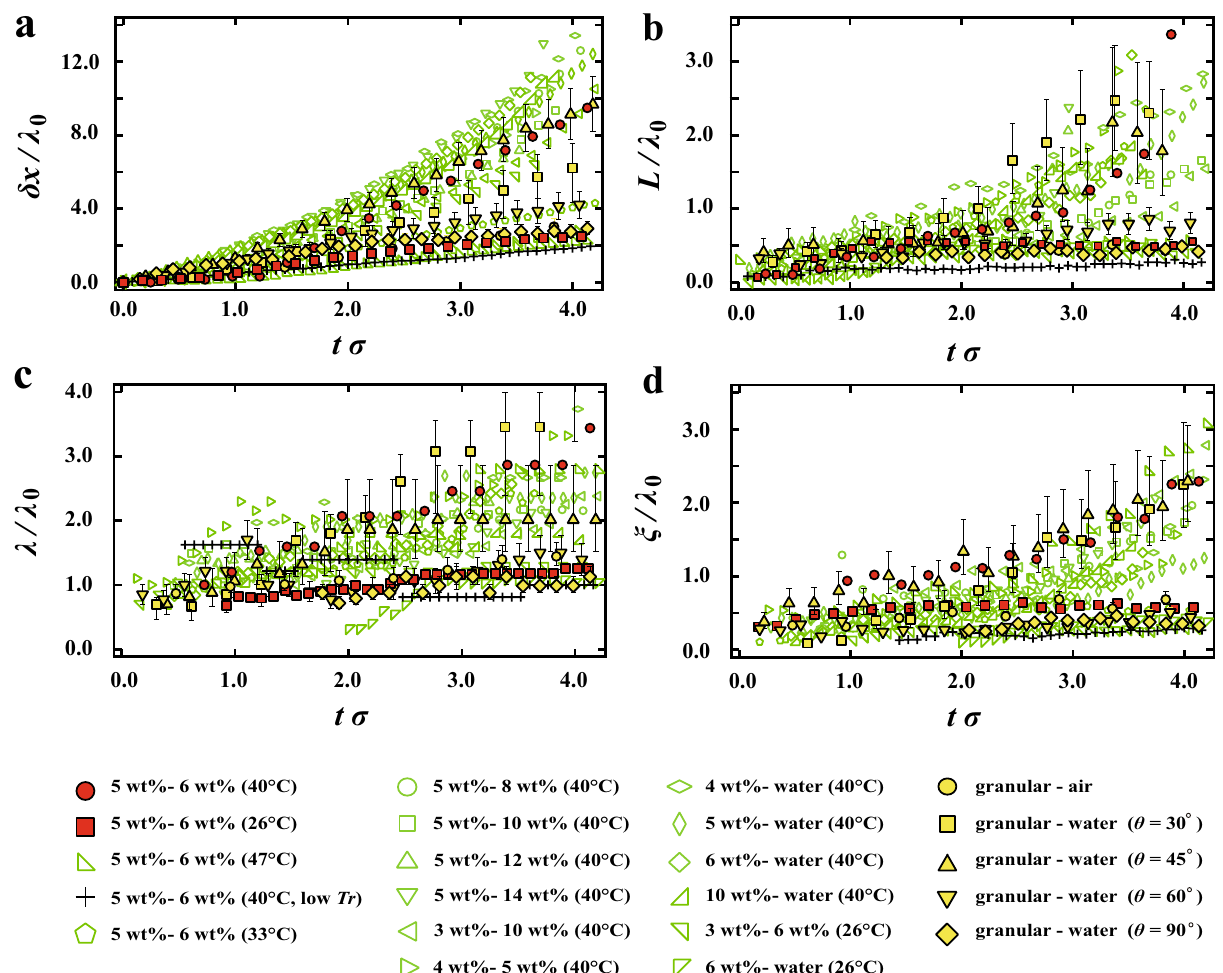
Figure 7. Time evolutions of the instability with respect to normalized time t σ in the physical gels and the granular systems. ( a ) normalized front position δ x / (cid:31) 0 , ( b ) normalized thickness of flowable region L / (cid:31) 0 , ( c ) normalized mean distance between the fingers (cid:31) / (cid:31) 0 , ( d ) normalized mean width of the fingers ξ/ (cid:31) 0 . The error bars for the granular systems correspond to the standard deviation of the